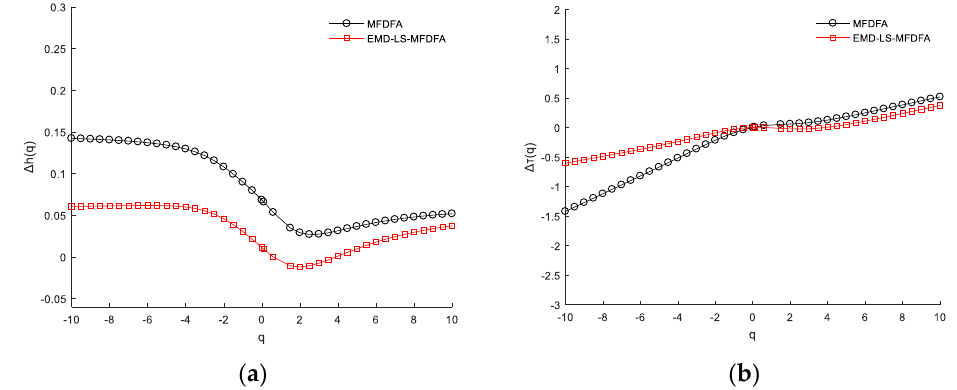
Figure 1. The relationship between Hurst index and quality index and theoretical value: ( a ) Figure